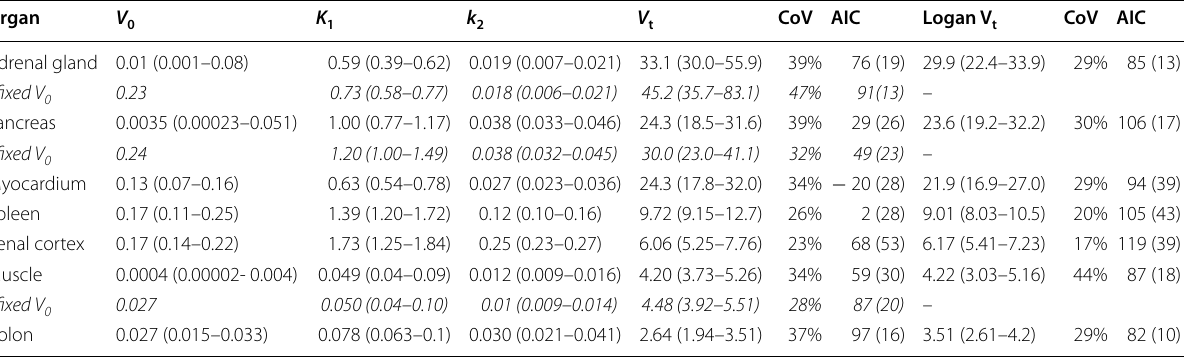
Values are presented as median (interquartile range) or mean (standard